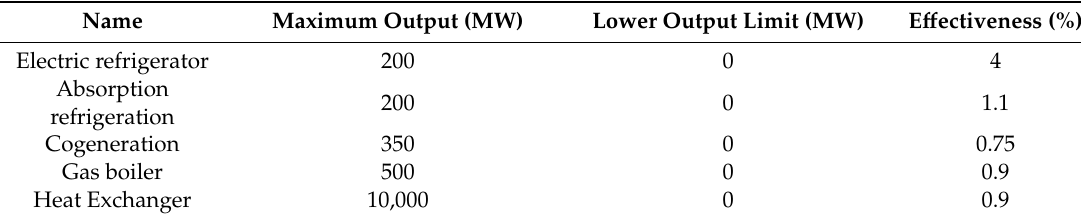
Table 3. CCHP related parameters.